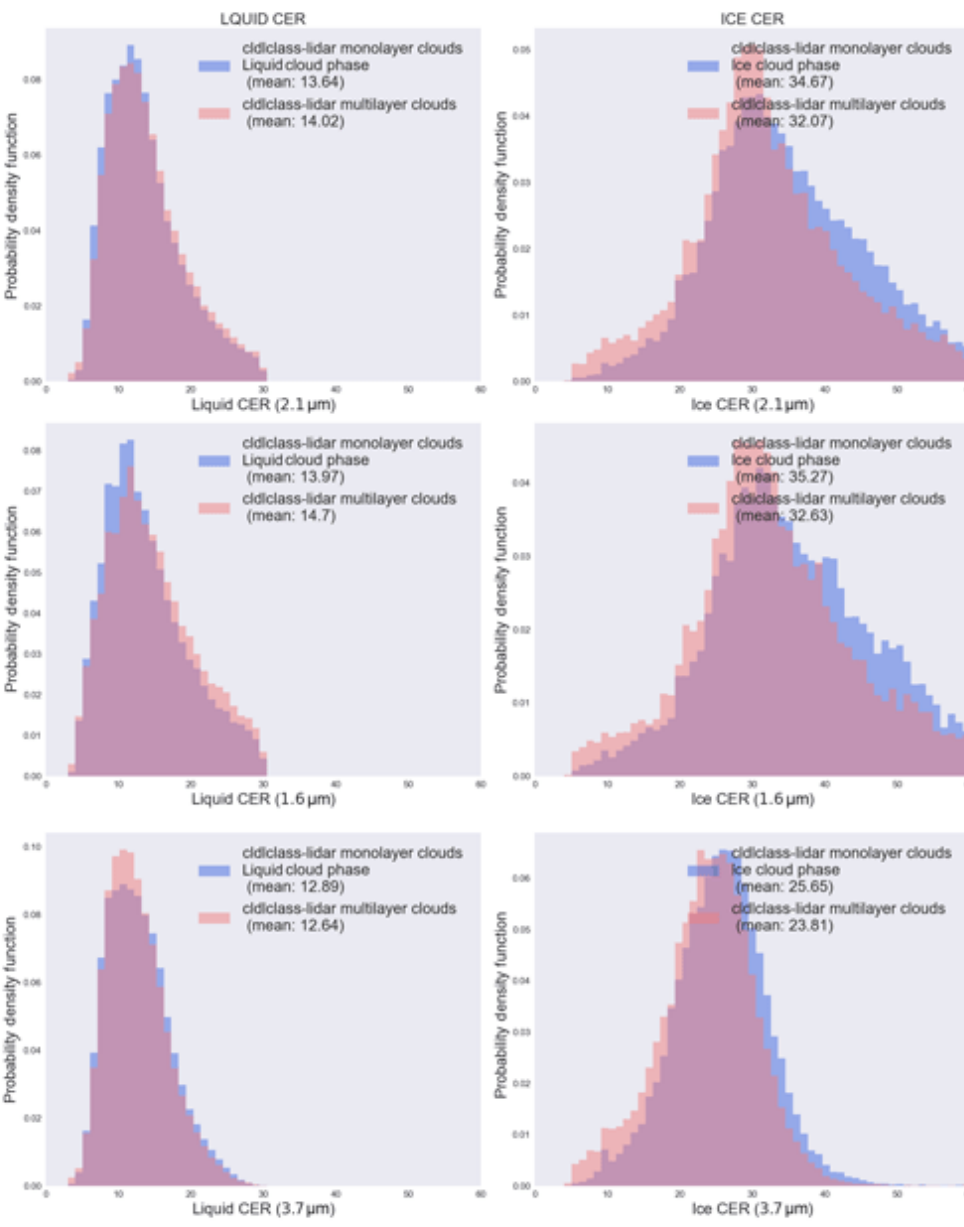
Figure 9. The same as Fig. 8 but for the population that have MYD06 cloud optical thickness larger than 4 and after removing the cloudy pixels classified by the MYD06 multilayer cloud detection algorithm as multilayer clouds from the multilayer cloud population (in